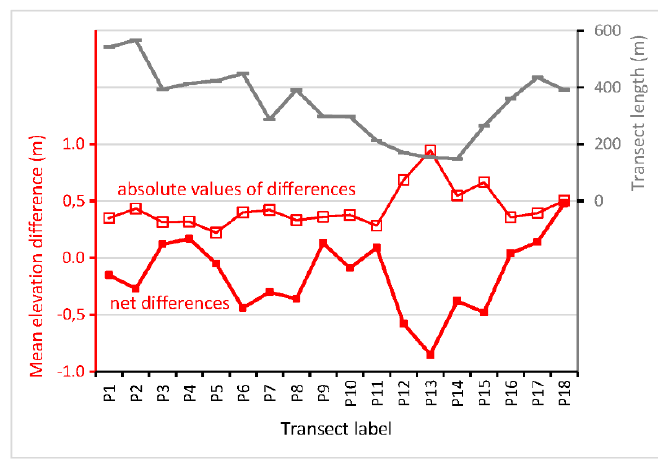
Figure 5. Downstream change in overall elevation difference in entire transect profiles in the Skalka inflow.